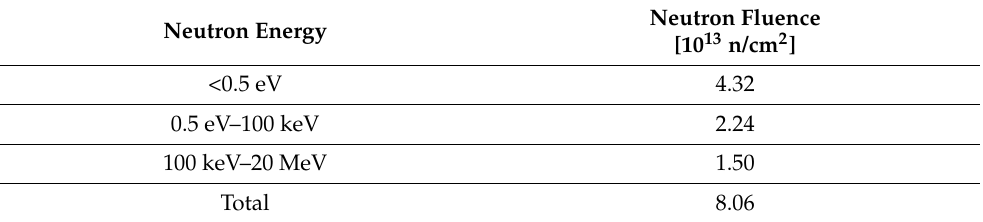
Table 4. Achieved neutron fluences—samples for mech testing.